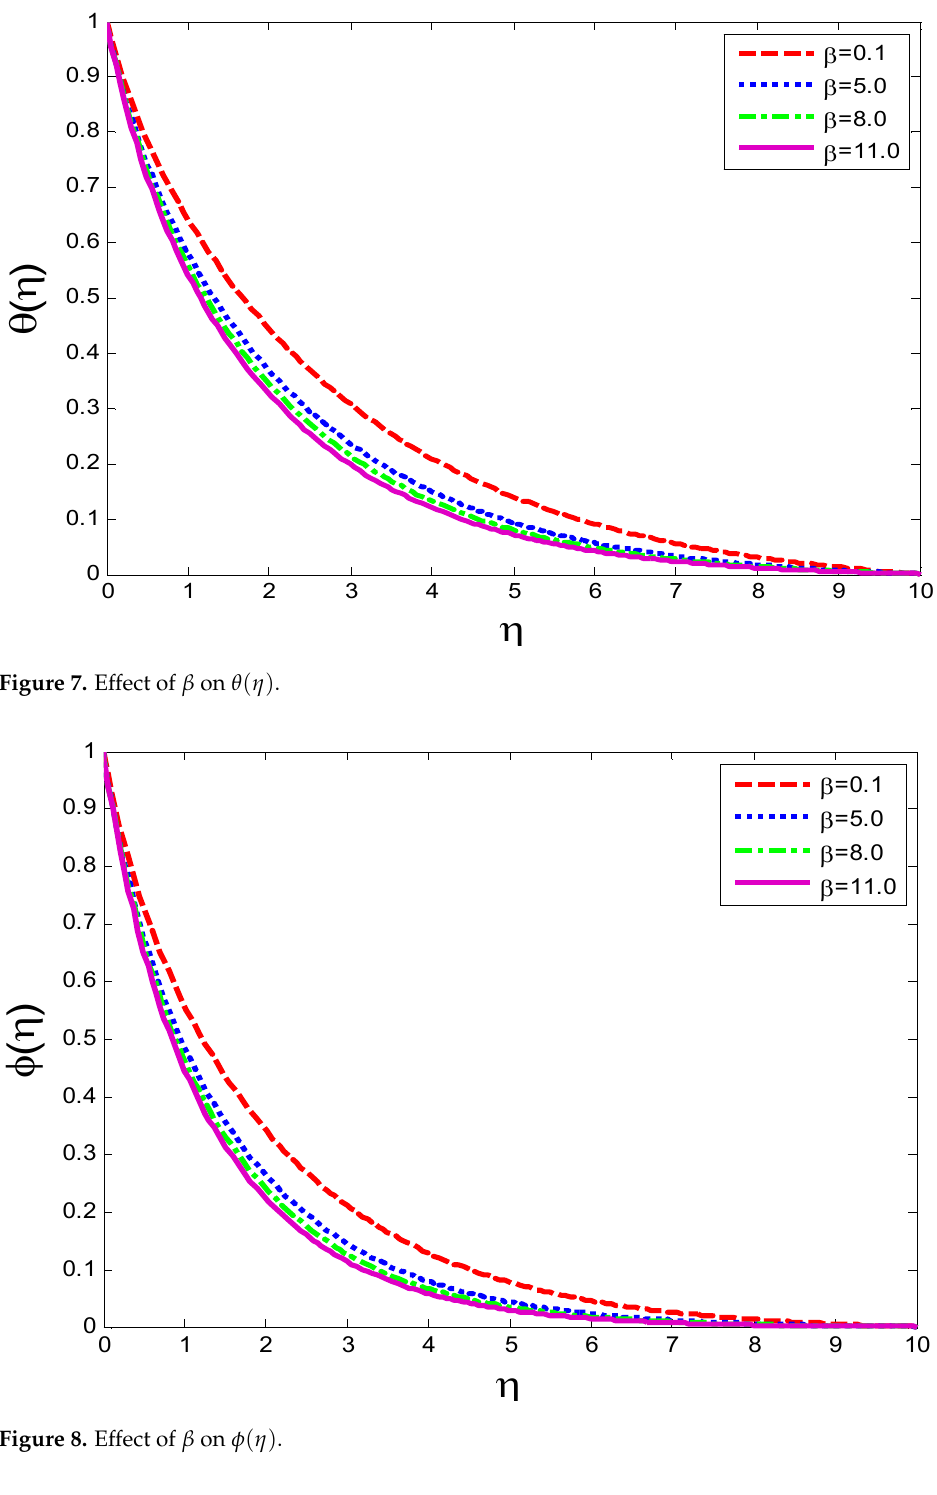
Figure 6. Effect of 𝛽 on 𝑓 (cid:4593) (cid:4666)𝜂(cid:4667) .